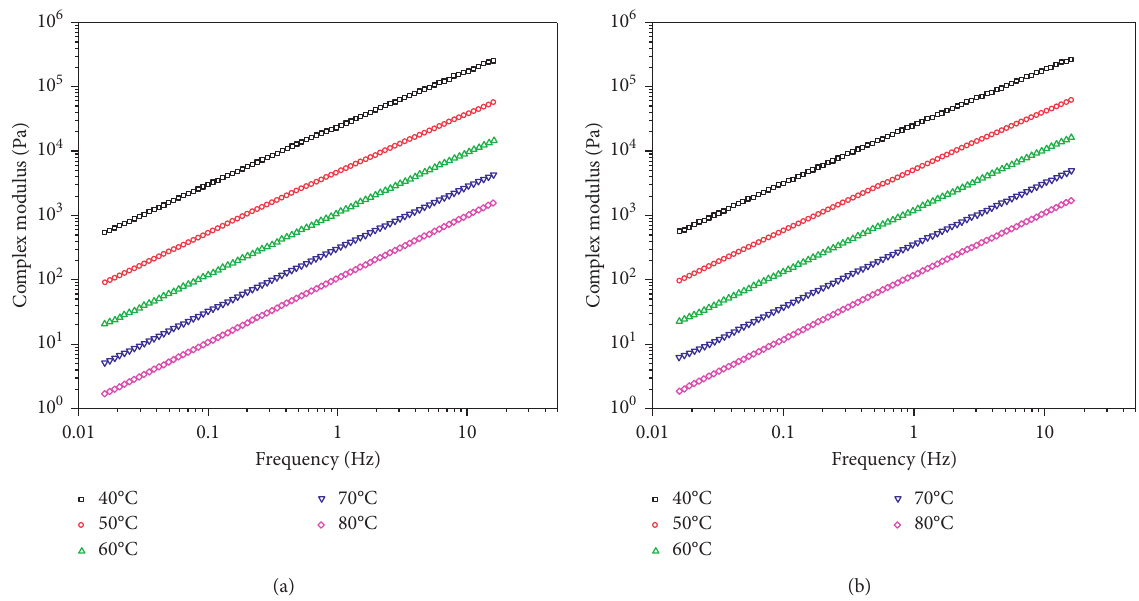
Figure 7: G ∗ results versus frequencies and temperatures of asphalt with and without nano-TiO asphalt.